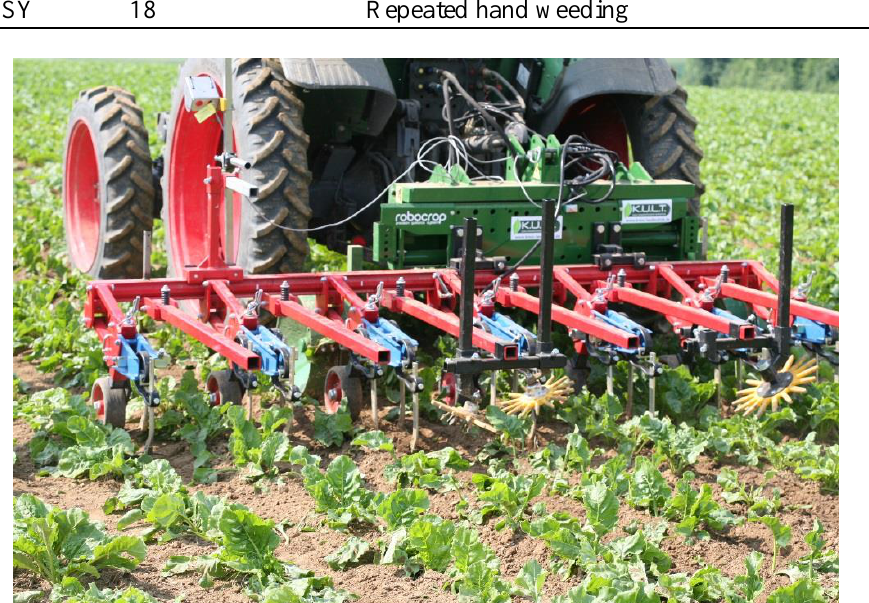
Figure 4. Photo of the Kult-robocrop ® hoe with a camera-based automatic steering system in sugar beet at 8-leaf stage at Ihinger